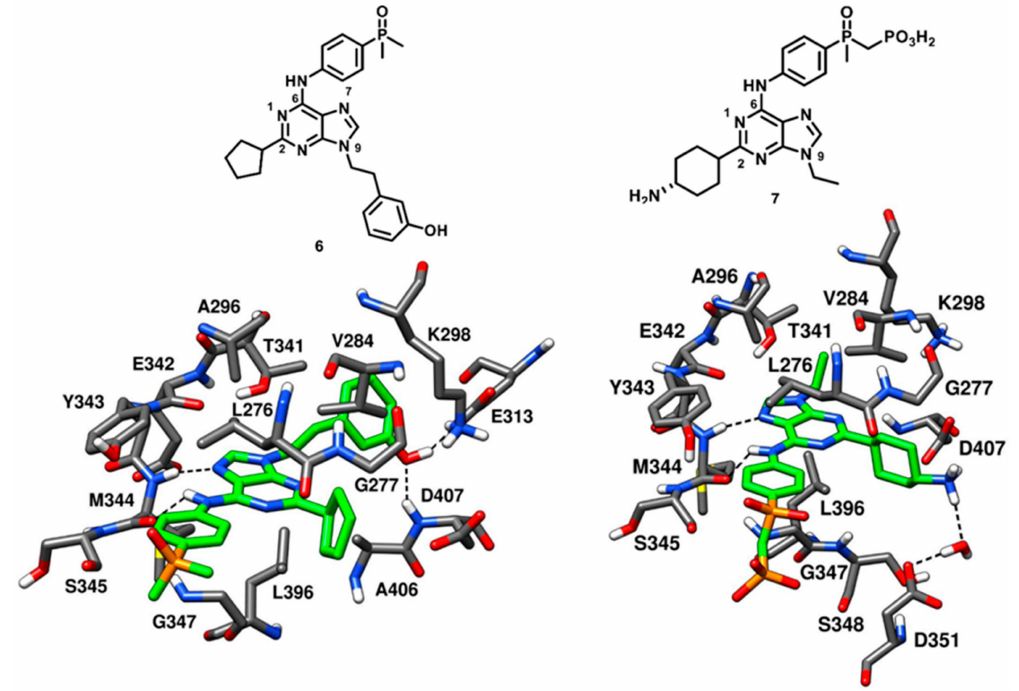
Figure 8. 2D structures of 6 and 7 . X-ray structures of c-Src kinase in complex with 6 (PDB ID: 2BDJ) and 7 (PDB ID: 2BDF). Active site residues of c-Src kinase and the enzyme–inhibitor H-bond interactions are